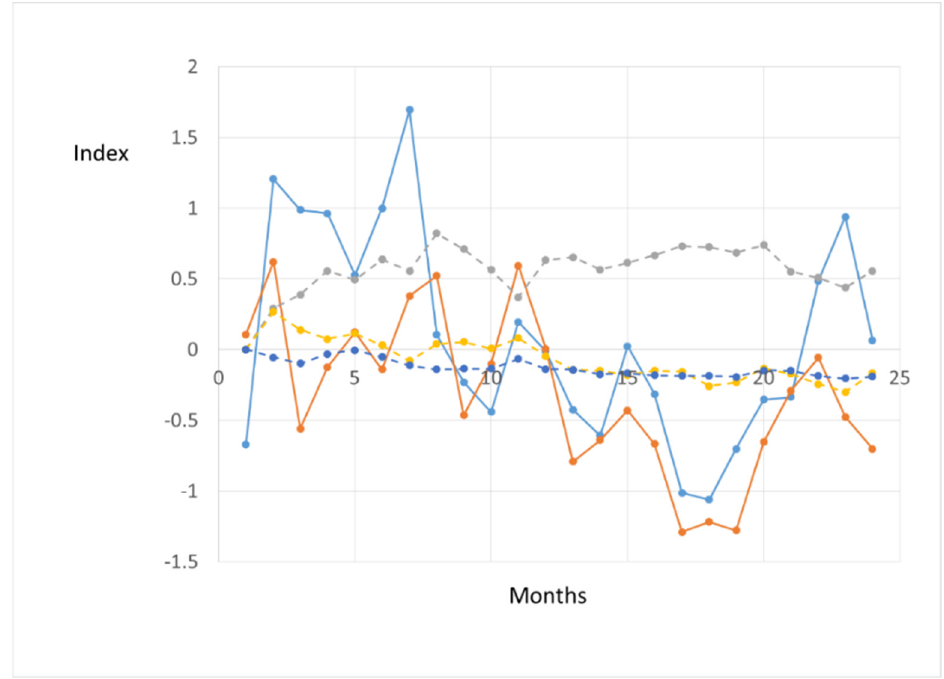
Figure A6. Backward LTSM prediction of monthly sentiment index (blue) using data from the broker’s own training tape (orange), and three other brokers (blue, grey, and yellow dash). The general downward tendency of the sentiment for the period but not much else can be predicted from other brokers’ tapes.